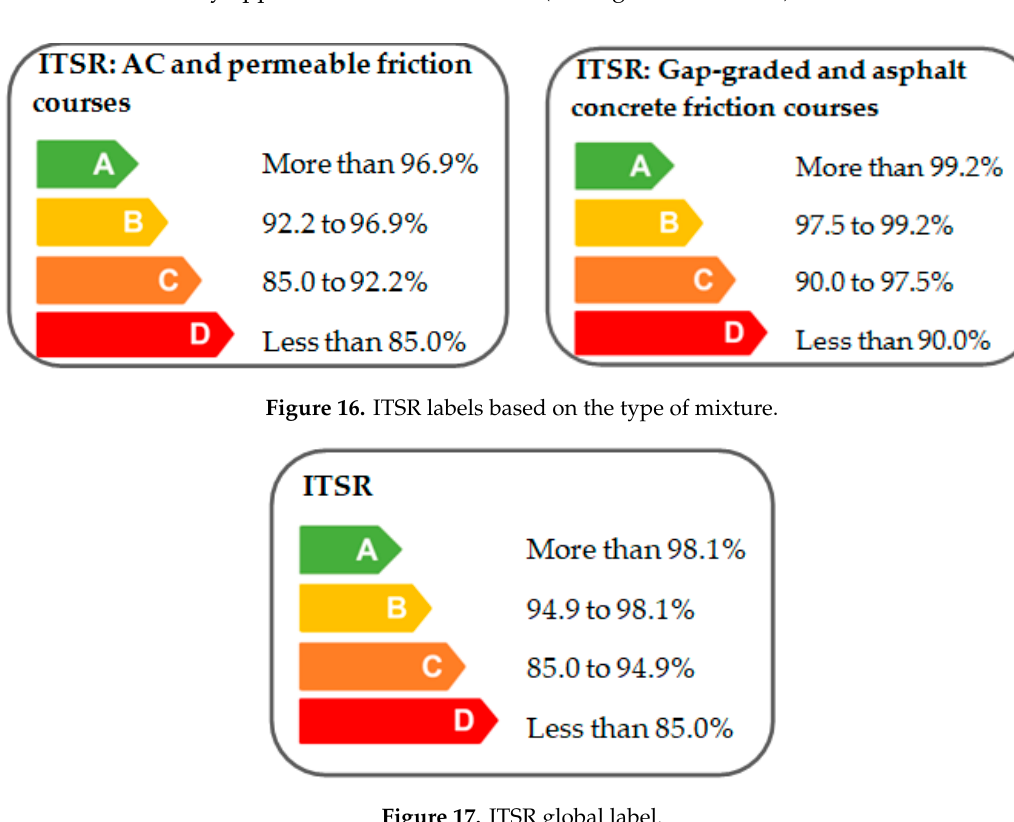
Figure 17. ITSR global label.